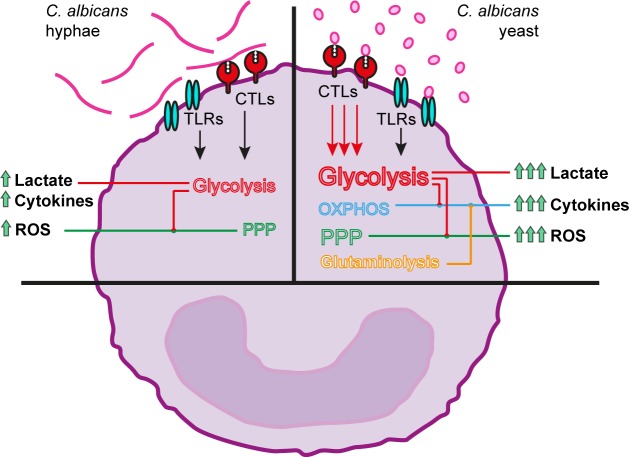
Overview of the immune and metabolic processes taking place in monocytes after systemic C. albicans recognition.C. albicans recognition by monocytes triggers a complex network of metabolic pathways that lead to the production of proinflammatory cytokines and ROS, and also the release of lactate to the extracellular space. Heat killing of C. albicans resulted in higher β-glucan exposure and subsequent dectin-1 recognition while shielding of β-glucans by mannans in hyphae prevents activation of the CTL signaling pathways. While heat-killed hyphae-derived responses mainly rely on the participation of glycolysis and the pentose phosphate pathway, the response to heat-killed yeast is a much more demanding process that requires the participation of glycolysis, oxidative phosphorylation, glutaminolysis and the pentose phosphate pathway through a process driven by an enhanced C-type lectin-derived signaling.